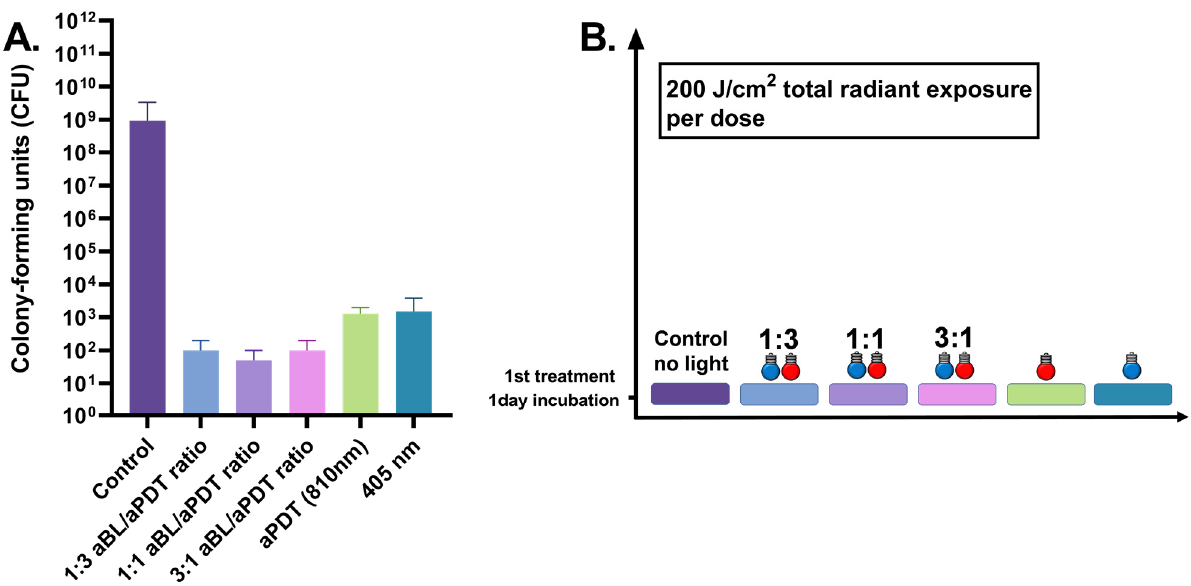
Figure 5. ( A ). Effects of different irradiance ratios of aBL and aPDT in the dual-light aPDT system in one-day S. aureus biofilm daily at 200 J/cm2. One-day S. aureus biofilm, single dose, aBL vs. dual-light 1:3 aBL/aPDT ratio at 200 J/cm2, p = 0.0022; aBL vs. dual-light 1:1 aBL/aPDT ratio, p = 0.0022; aBL vs. dual-light 3:1 aBL/aPDT ratio, p = 0.0022; aPDT vs. dual-light 1:3 aBL/aPDT ratio, p = 0.0022; aPDT vs. dual-light 1:1 aBL/aPDT ratio, p = 0.0022; aPDT vs. dual-light 3:1 aBL/aPDT ratio, p = 0.0022. aBL vs. aPDT, p = ns; dual-light aPDT: 1:3 aBL/aPDT ratio vs. 1:1 aBL/aPDT ratio, p = ns; 1:3 aBL/aPDT ratio vs. 3:1 aBL/aPDT ratio, p = ns; 1:1 aBL/aPDT ratio vs. 3:1 aBL/aPDT ratio; p = ns. The y -axis displays the median of CFUs. Six assays were performed for each experiment, and the control biofilm was performed in three assays. The 95% confidence interval (CI) is presented by using t-bars; ns = non-significant. ( B ). A schematic representation of the experi- ment.